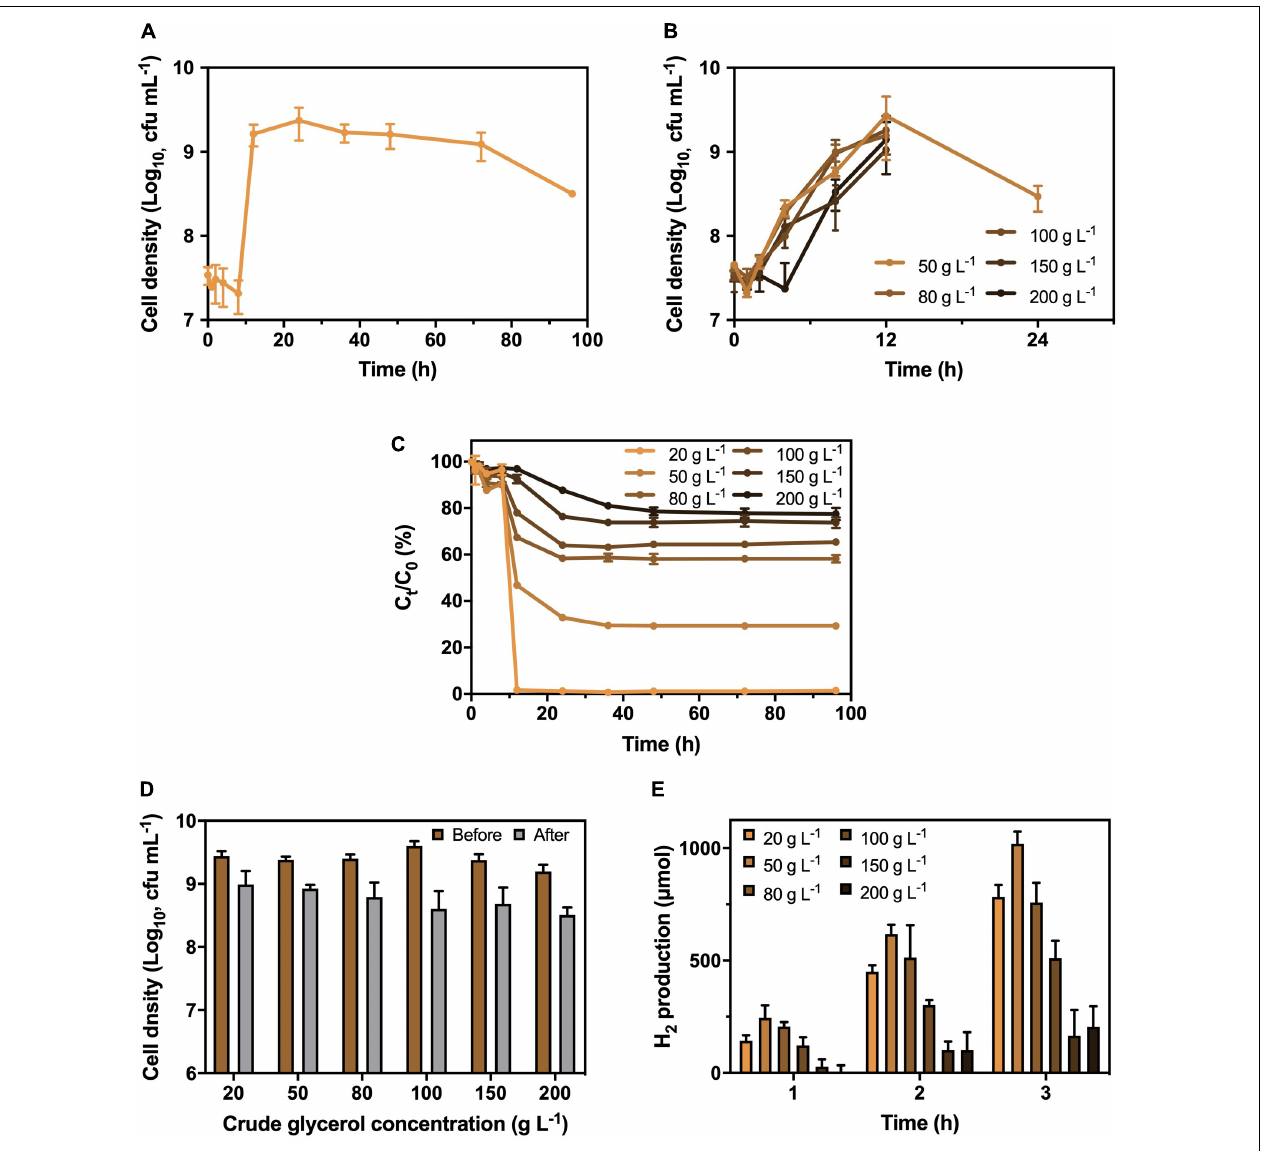
FIGURE 1 | Growth pattern of K. pneumoniae (A) under 20 g L − 1 CG and (B) 50 to 200 g L − 1 CG, (C) corresponding residual CG in culture medium as well as (D) cell density and (E) H 2 production in 3 h by K. pneumoniae after hydrogenase induction under different CG concentrations.